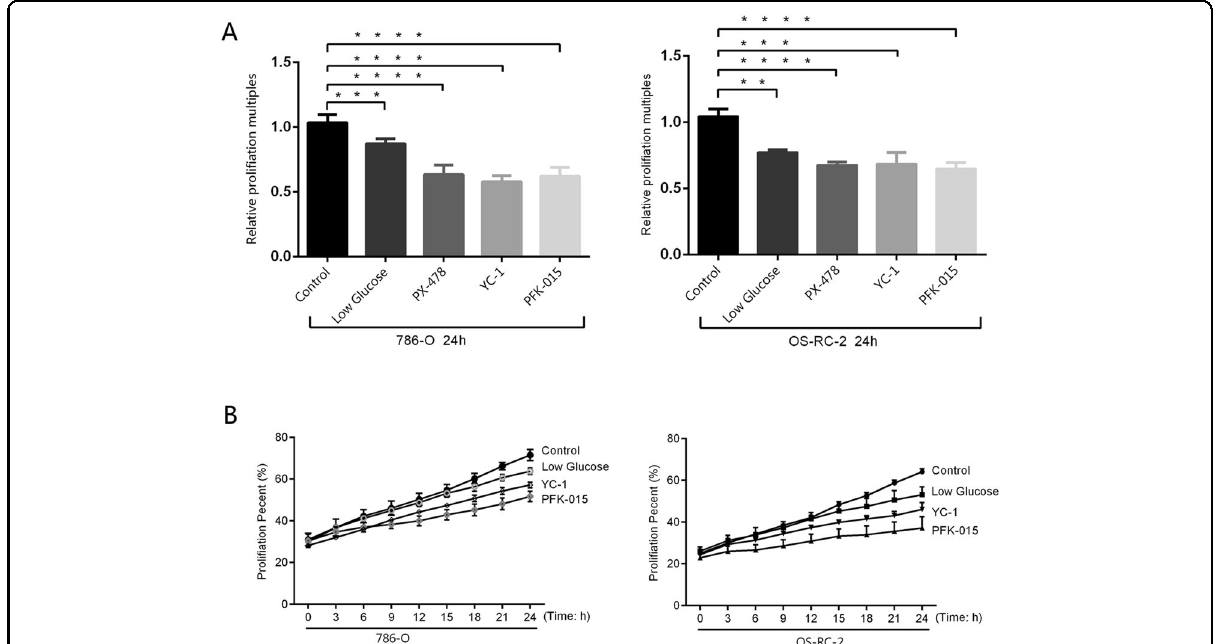
Fig. 1 Cell proliferation levels of 786-O and OS-RC-2 cell lines under different cultivation conditions. A An MTT assay was used to detect the proliferation of the two cell lines after different interventions. B The cell growth curves of the two cell lines under different intervention conditions were observed with a real-time live-cell analysis system. Independent experiments were performed in triplicate. Data are expressed as mean ± SD. * P < 0.05, ** P < 0.01, *** P < 0.001 and **** P <